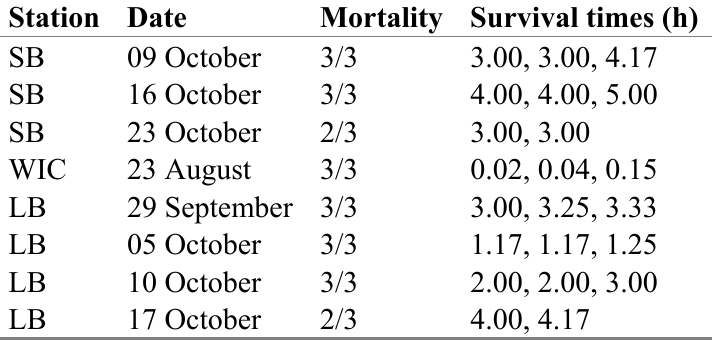
Table 1. Mortality and survival times within 24 h in DSP mouse bioassay.